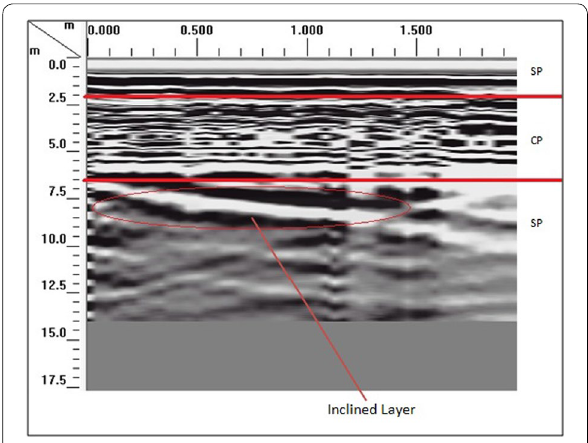
Fig. 4 GPR results for Roorkee using 35 MHz antenna ( SP poorly graded sand; CL lean clay or clay of low